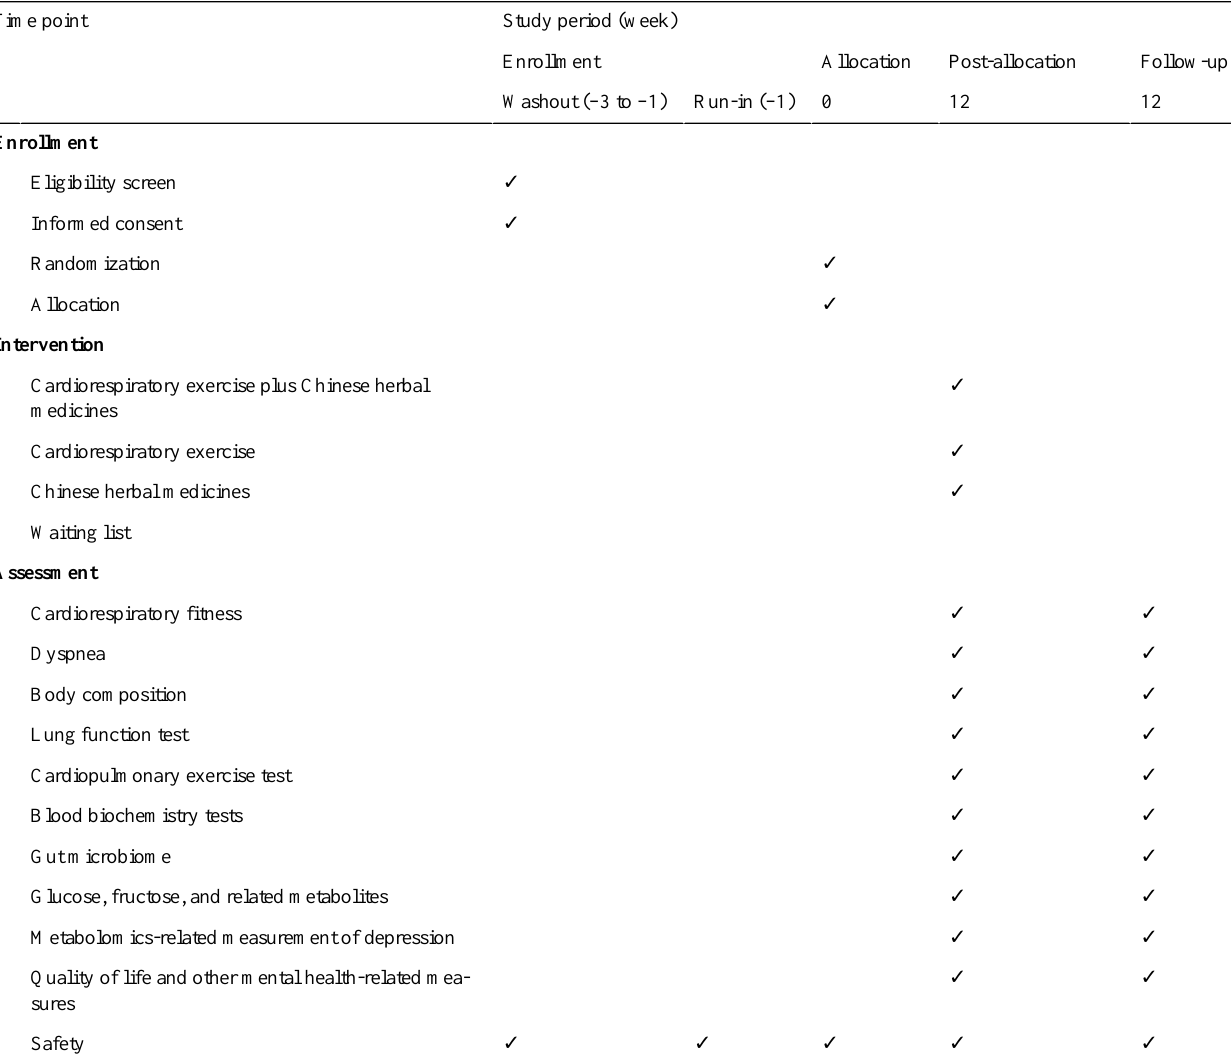
Table 3. Schedule of enrollment, interventions, and assessments in the